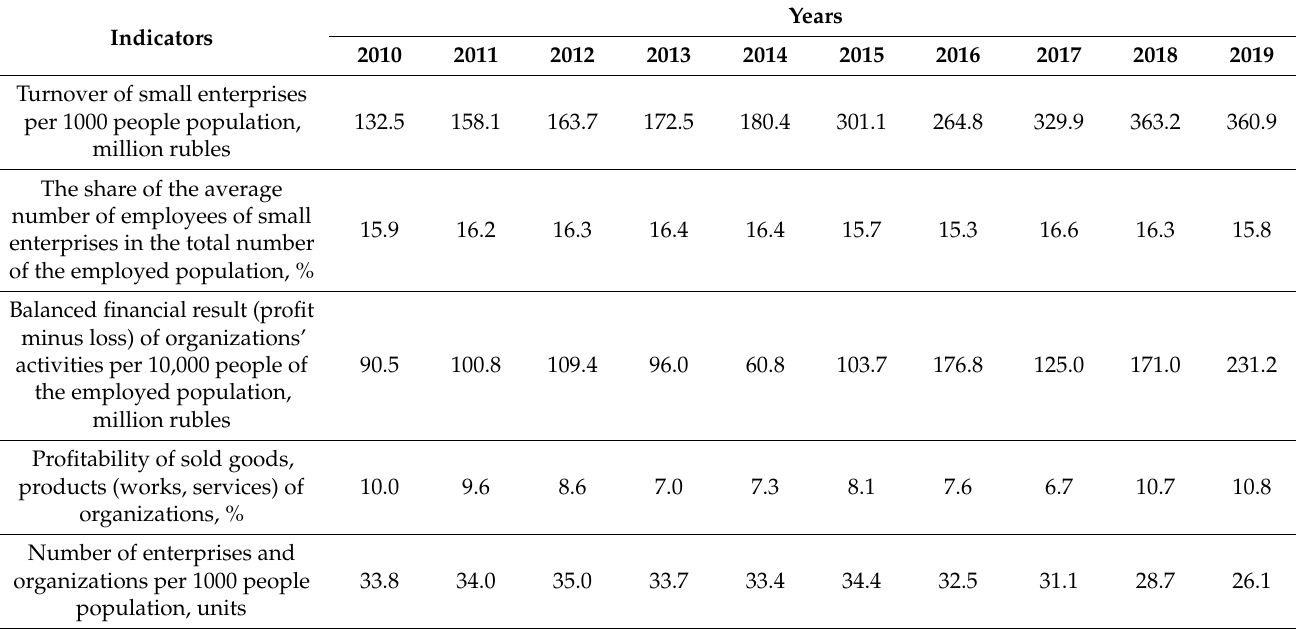
Table 5. Main indicators characterizing the macro-regional block “Business” in the Russian Federation in